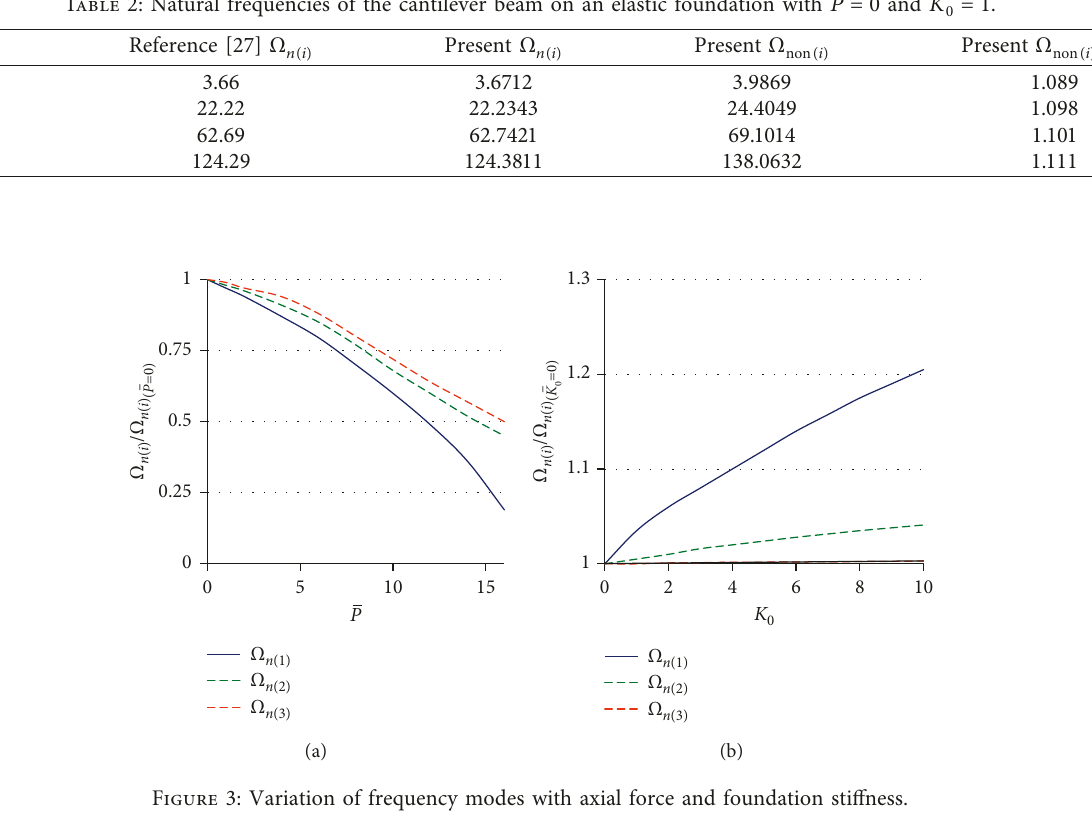
Table 1: First five natural frequencies ( Ω